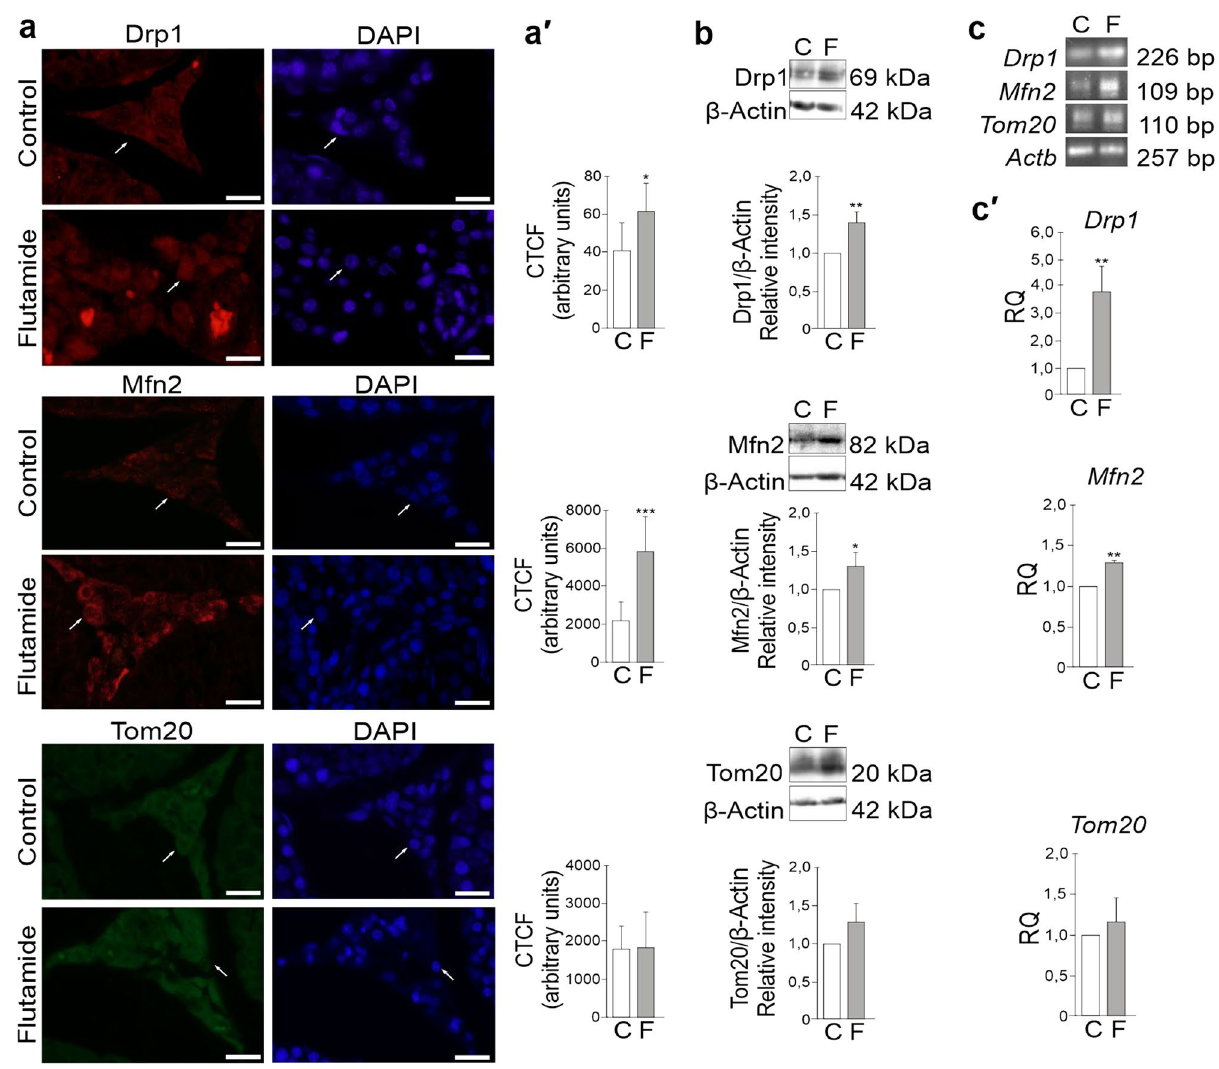
Figure 6. Immunofluorescence localization of Drp1, Mfn2, and Tom20 (control protein) ( a ), quantitative image analysis displayed in corrected total cell fluorescence (CTCF) ( a ′ ) , Drp1, Mfn2, and Tom20 protein levels ( b ) and Drp1, Mfn2, and Tom20 mRNA ( c , c ′ ) expression levels in testes of control and flutamide-treated rats. Bars represent 20 μm. ( a ) Representative microphotographs show positive signals for Drp1 and Mfn2 (red) and for Tom20 (green) localized to Leydig cells (arrows). Cell nuclei were stained with DAPI (blue) (arrows). Note higher signal intensity of Drp1 and Mfn2 but not of Tom20 in Leydig cells of flutamide-treated rats compared to controls ( a ′ ). ( b ) Representative western blots and the relative levels of Drp1, Mfn2, and Tom20 proteins normalized to β-Actin, which served as an internal protein loading control. Drp1, Mfn2, and Tom20 protein levels within control testes were given a value of 1. Displayed are the cropped blots and original blots are provided in Supplementary Fig. S6. ( c , c ′ ) Representative RT-PCR and qRT-PCR analyses of Drp1, Mfn2, and Tom20 expression levels, respectively. Relative quantification (RQ) is expressed as mean ± SD. Note significant increase in Drp1 and Mfn2 protein and mRNA levels and slight (not statistically significant) increase in Tom20 protein and mRNA levels in testes homogenates of treated rats compared to controls. Statistically significant differences from control values are denoted as * P < 0.05; ** P < 0.01. Control (n = 6) and flutamide-treated (n = 6)